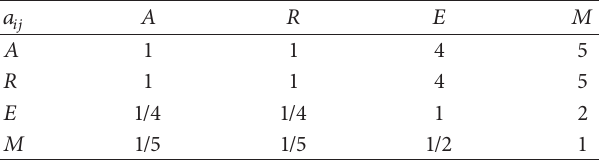
Table 6: The criteria hierarchy judgment matrix.